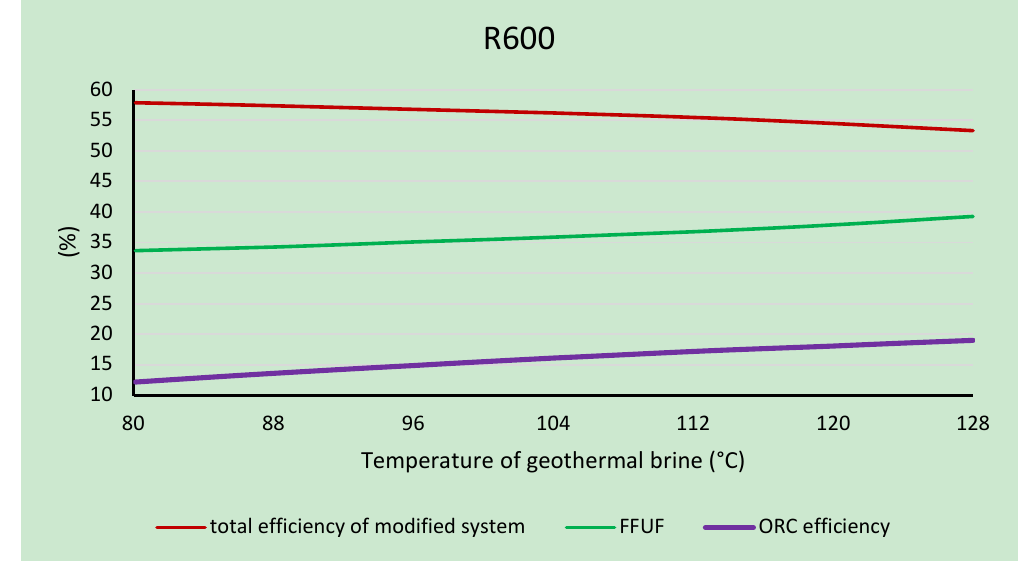
Figure 7. Summary of individual results for the designed modified ORC power plant supported by a gas turbine with R600 as a working fluid.